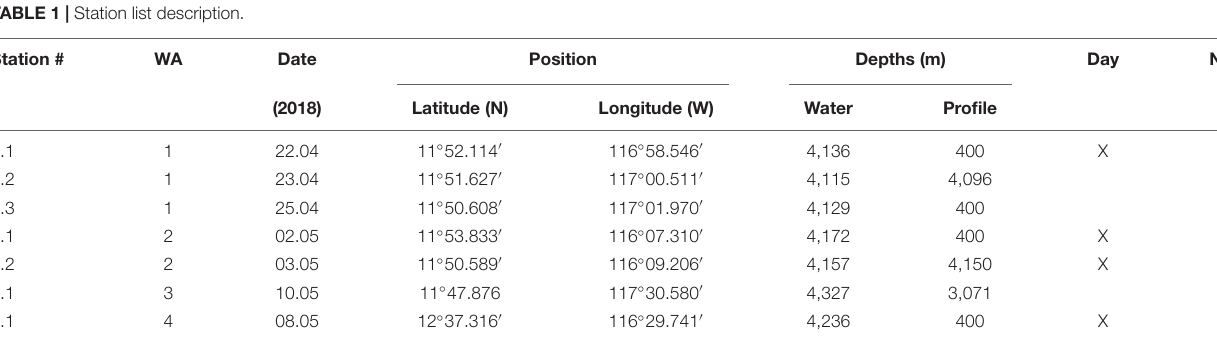
TABLE 1 | Station list